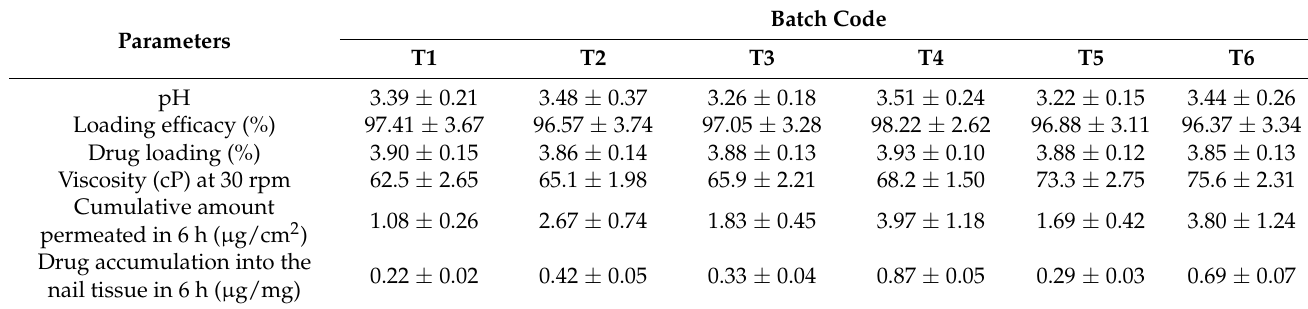
Table 2. Physicochemical characteristics of preliminary batches (T1–T6).